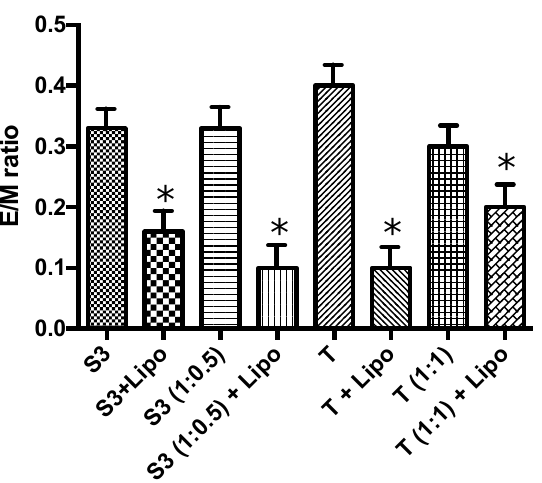
Figure 8. Pyrene E/M ratio decrease. Reported data represent the mean of three experiments ± S.E. ** p ≤ 0.01 compared to labelled vesicles in absence of liposomes (* p < 0.05).